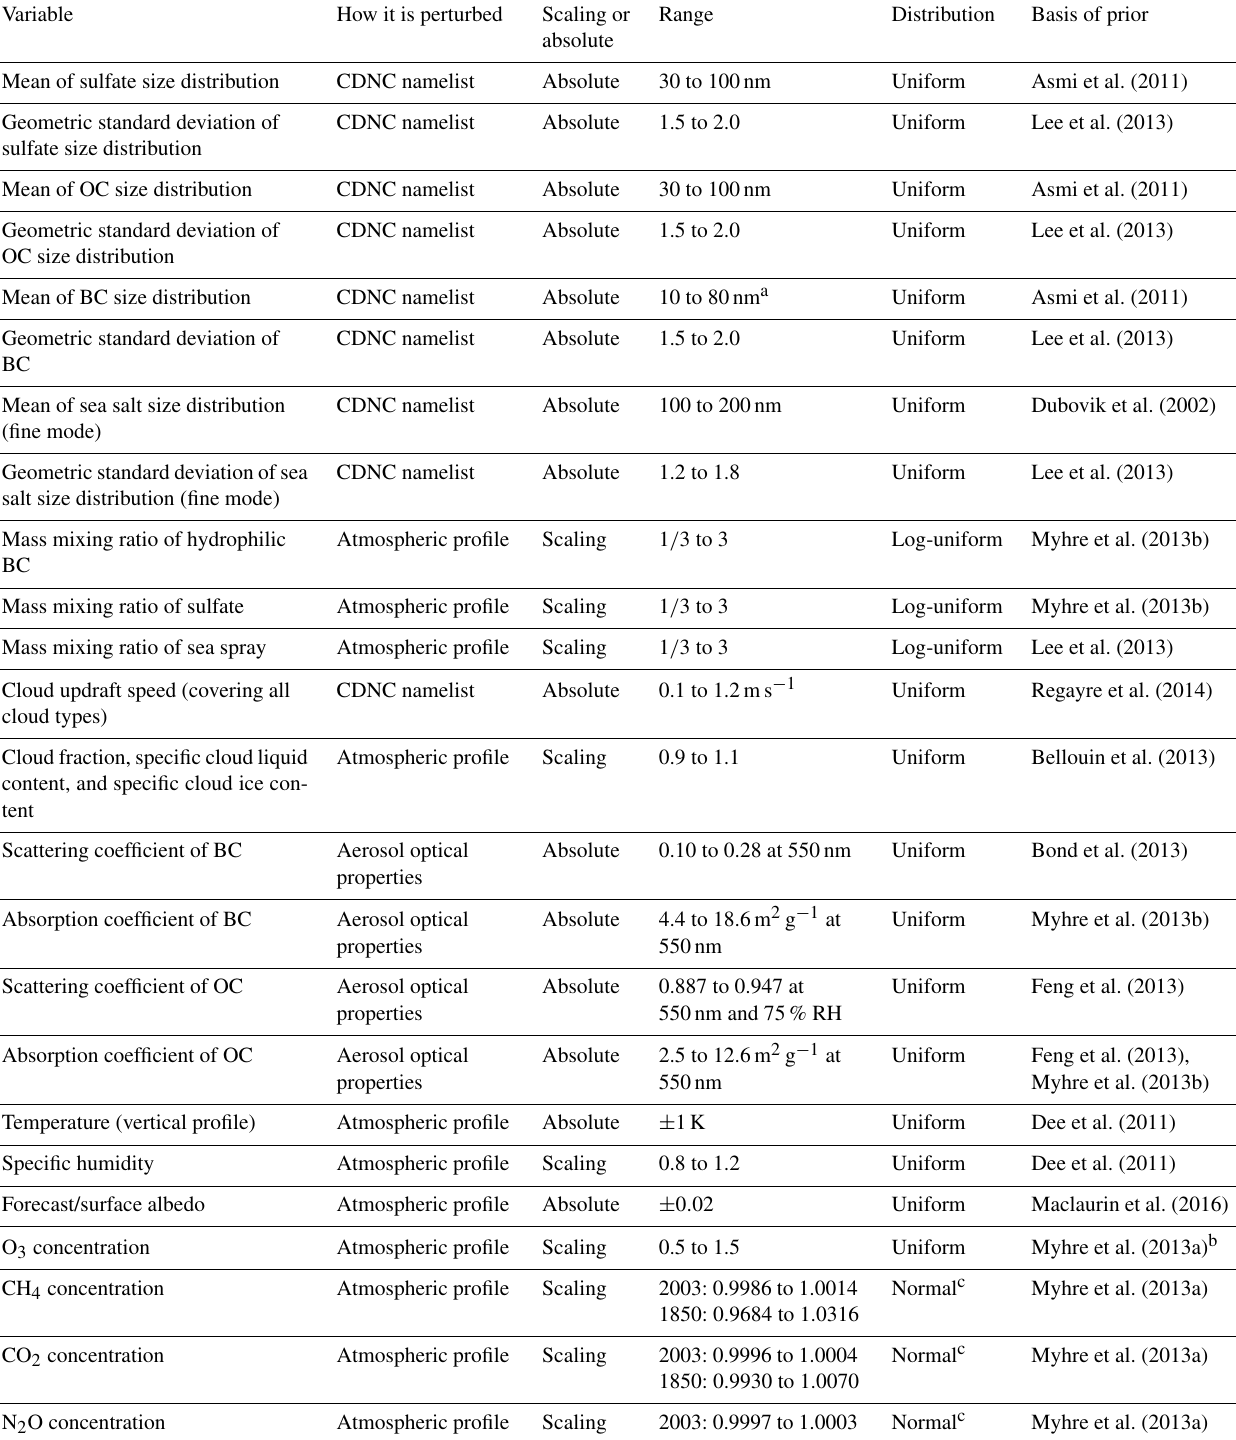
Table 6. Variables perturbed and their ranges for use in the 240-member perturbed parameter